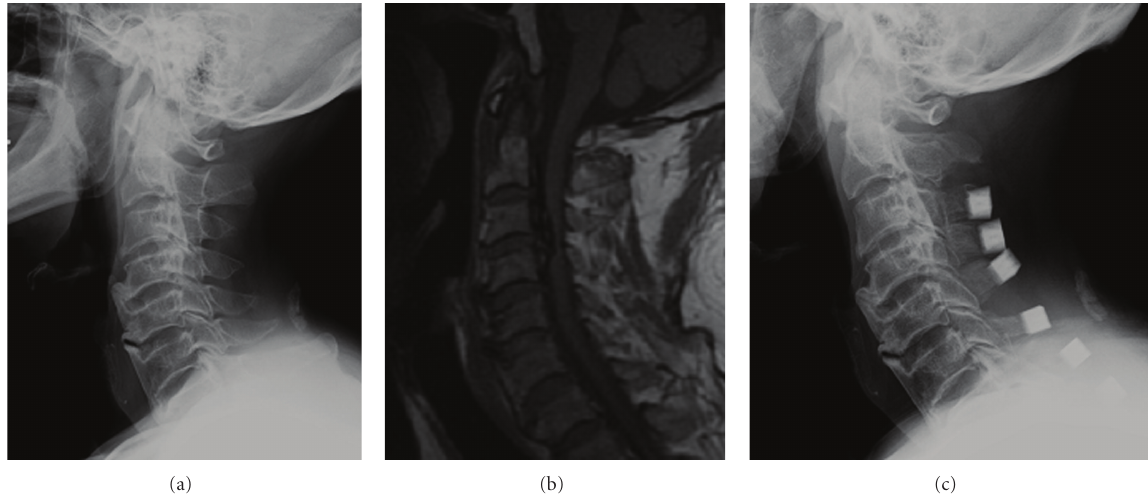
Figure 1: Preoperative image ((a): plain radiograph, lateral image, (b): MRI, sagittal image, and T1 weighted image). (a) Preoperative plain radiograph demonstrates significant multilevel cervical spondylosis. (b) In preoperative MRI, spinal cord compression at C3-4 due to OPLL is found. (c) Laminoplasty is performed using hydroxyapatite spacers from C3 to C7. MRI: Magnetic resonance imaging. OPLL: Ossification of posterior longitudinal